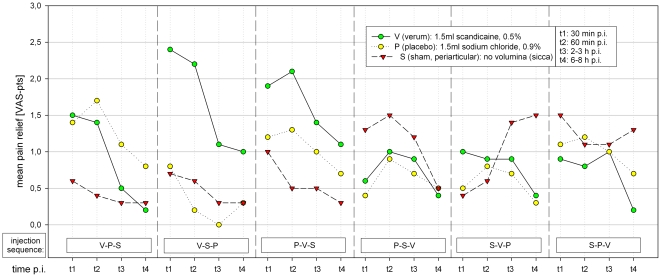
Period effect in sequences.